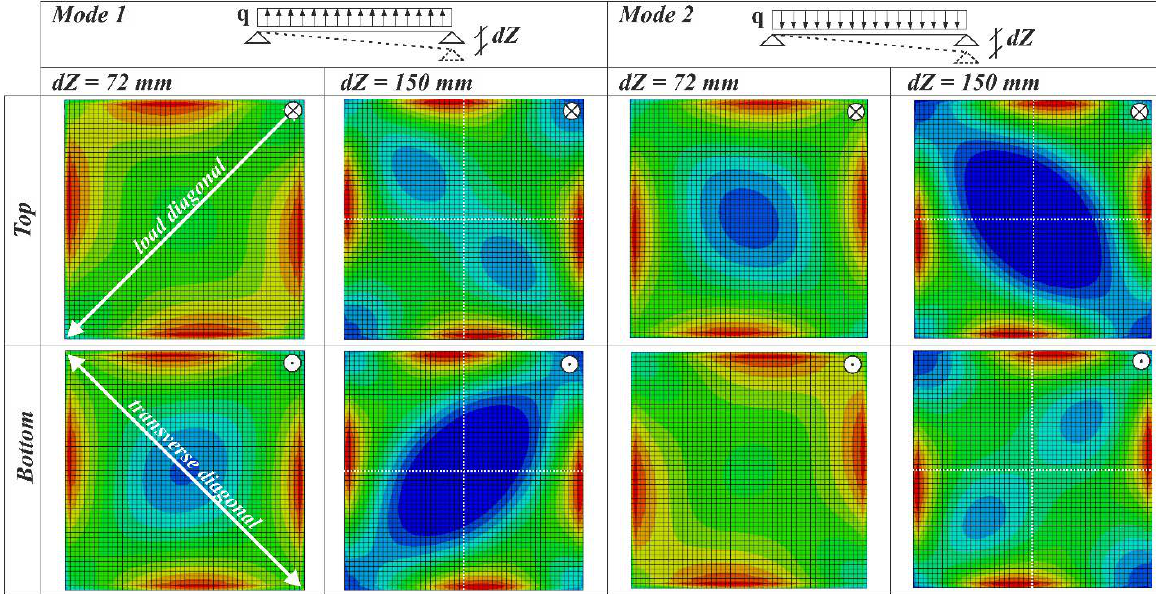
Fig. 6 Qualitative maximal principal stress states of an 8 mm pane due to two cold bending states.